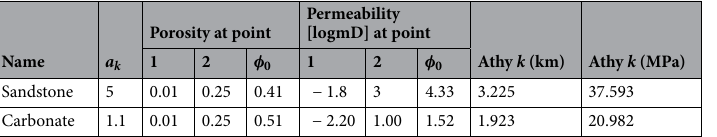
Table 2. Rock properties. Anisotropy = a k . Porosity and rock permeability values used to generate multipoint curves and rock saturation endpoint values for bulk rock. φ 0 = maximum (depositional) porosity of rock 7 . These values were used to determine the rock permeability from porosity shown on Fig.